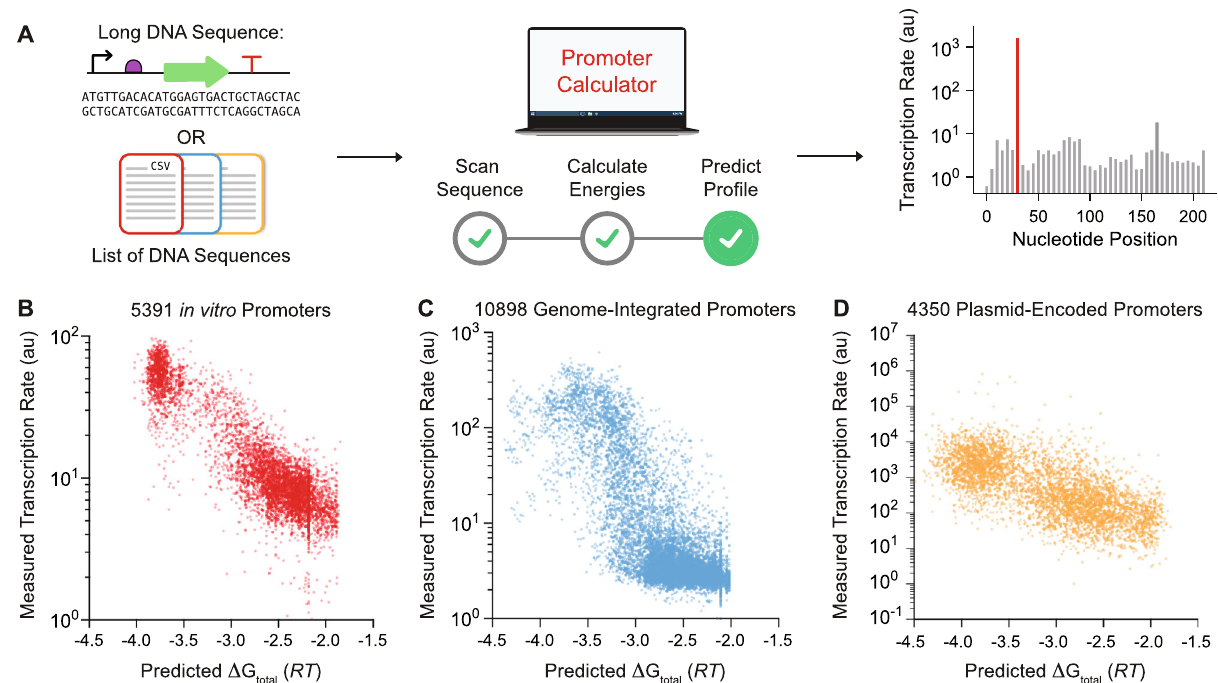
Fig. 3 | Validation of Sequence-to-Function Model on Diverse Promoters. A Arbitrary DNA sequences are inputted into the model to predict its transcrip- tional pro fi le (transcription rates vs. nucleotide positions) without start site infor- mation. B Model comparisons on 5391 designed promoters (LaFleur et al., this study) are compared to in vitro transcription rate measurements ( R 2 =0.79, Spearman ’ s ρ =0.80,MAE=0.33 RT ,MSE=0.18 RT ). C Modelpredictionson10898 genome-integrated modular promoters 16 characterized by Urtecho et al. are